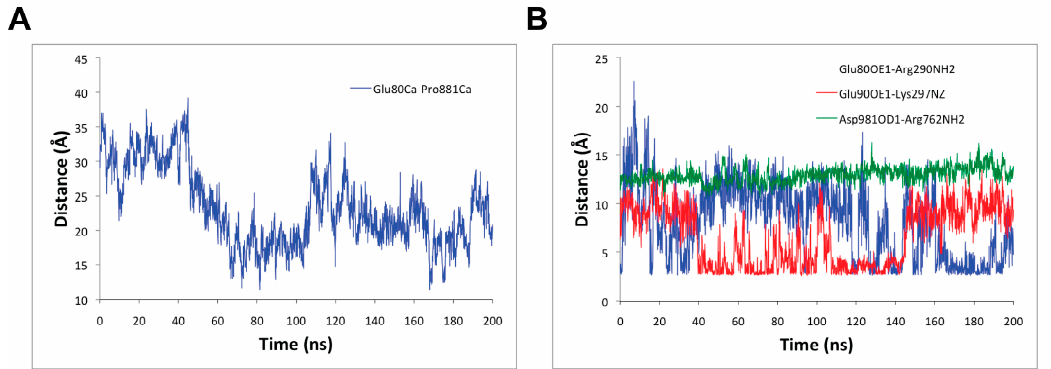
Figure 5. Distances ( A ) between alpha carbon atoms of Glu80 belonging to the loop joining helices M1 and M2 and Pro881 belonging to the loop joining helices M7 and M8 both in the lumen as function of time; and ( B ) between the side chain of the carboxyl oxygen OE1 of Glu80 and the –NH group of Arg290 in SERCA1a, side chain of the carboxyl oxygen OE1 of Glu90 and the –NH group of Lys297 in SERCA1a and the side chain of the carboxyl oxygen OD1 of Asp981 and the –NH group of Arg762 in SERCA1a. Furthermore, as shown in Figure 5B, the distances between the side chain of the carboxyl oxygen OE1 of Glu80 (of the loop joining helices M1 and M2) and the –NH group of Arg290 (in helix M4) in SERCA1a, and the side chain of the carboxyl oxygen OE1 of Glu90 (in helix M2) and the –NH group of Lys297 (in helix M4) in SERCA1a fluctuated and alternated from one state to another with average values of 6.2 ± 3.3 Å and 7.0 ± 3.0 Å, respectively, during the last 100 ns of the MD simulation. A closer